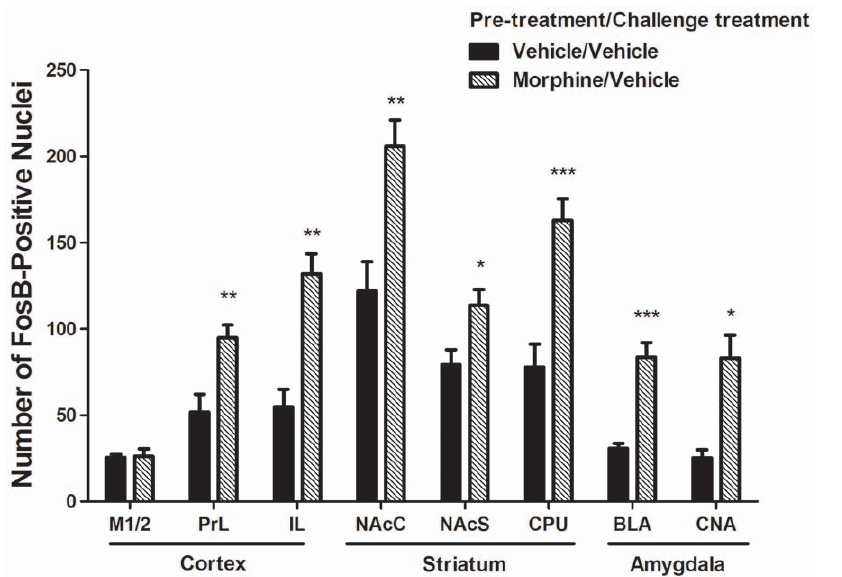
Figure 5. Quantitative analyses of FosB/ D FosB immunoreactivity from subjects from the vehicle and morphine pre-treatment groups following vehicle injection and motor activity testing on day 16. The quantification of the D FosB/FosB expression was determined by immunohistochemistry from multiple sections in each of the following brain regions: PL, IL, M1/2, NAcC, NAcS, CPU, CNA and BLA. Data are shown as mean 6 S.E.M of n=4–8 mice from each treatment group. * P , 0.05, ** P , 0.01, and *** P , 0.001 vs. vehicle pre-treatment